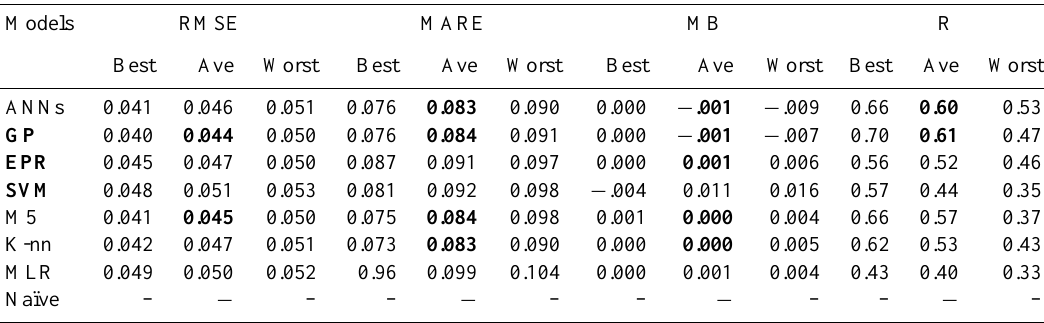
Fig. 7. Scatter plots of observed and predicted peat moisture content, (a) ANNs, (b) GP, (c) EPR, (d) SVM, (e) M5, (f) K-nn, and (g) MLR. Table 10. Testing results of all models applied to the Peat moisture dataset.